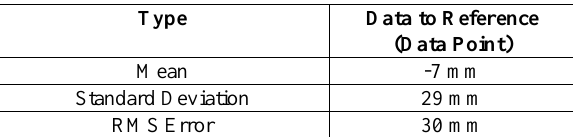
Table 3 Deviation statistics between Faro laser scanner and the proposed system